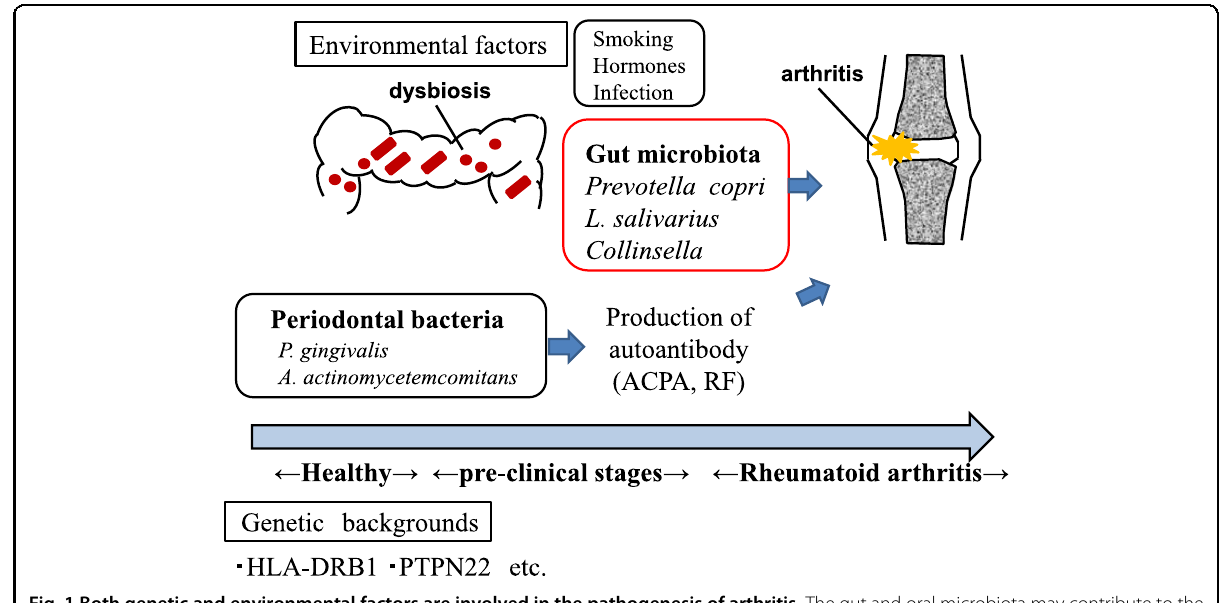
Fig. 1 Both genetic and environmental factors are involved in the pathogenesis of arthritis. The gut and oral microbiota may contribute to the development of arthritis. P. gingivalis Porphyromonas gingivalis , A. actinomycetemcomitans Aggregatibacter actinomycetemcomitans , L. salivarius